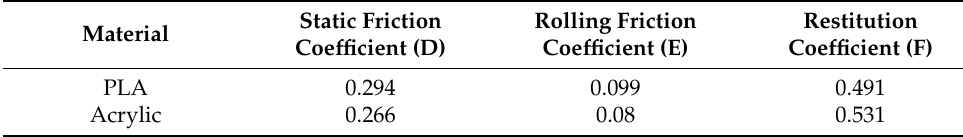
Table 10. The optimization results of the